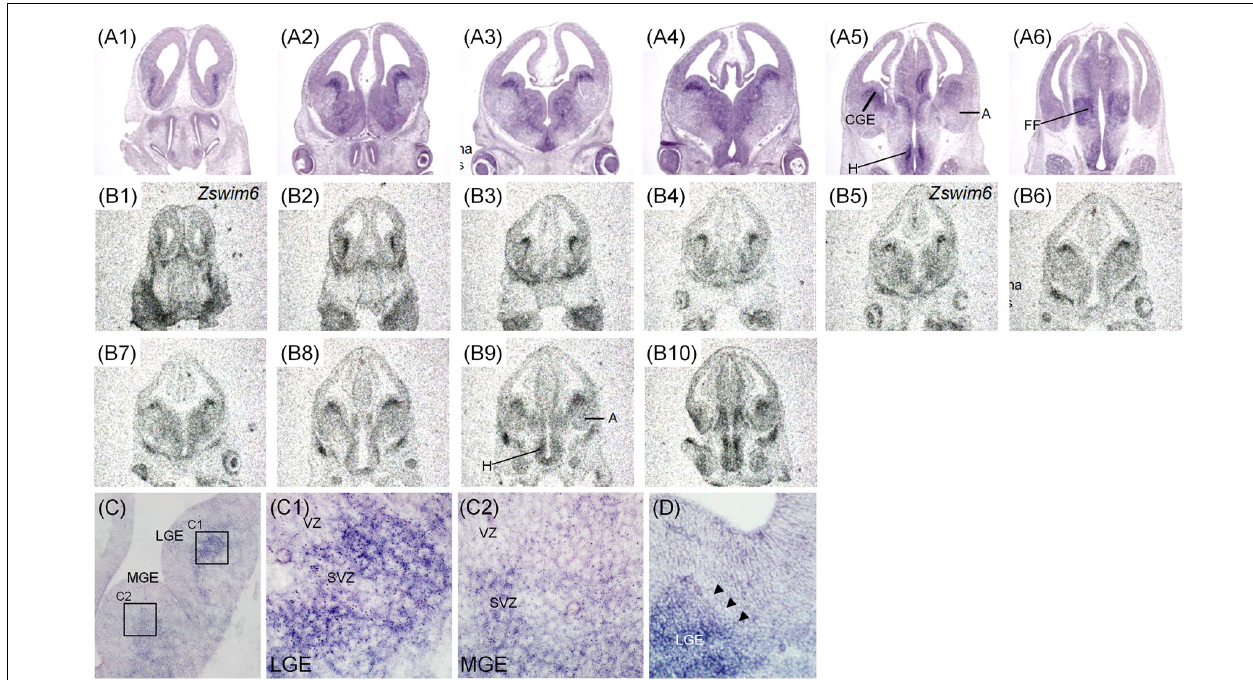
FIGURE 2 | Zswim6 mRNA expression pattern in E12.5 mouse forebrain. Expression pattern of Zswim6 mRNA analyzed by in situ hybridization with digoxigenin-labeled probes (A1–A6) and 35 S-labeled probes (B1–B10) from rostral to caudal levels. (C) Zswim6 is strongly expressed in the SVZ of LGE (C,C1) , but is weaker in the SVZ of MGE (C,C2) . (D) Zswim6 is highly expressed in the SVZ of LGE. There is a boundary at the dorsal-most part of the SVZ of LGE (arrowheads). A, amygdala; CGE, caudal ganglionic eminence; CP, cortical plate; H, hypothalamus; Hip, hippocampus; LGE, lateral ganglionic eminence; MGE, medial ganglionic eminence; MZ, mantel zone; SVZ, subventricular zone; VZ, ventricular